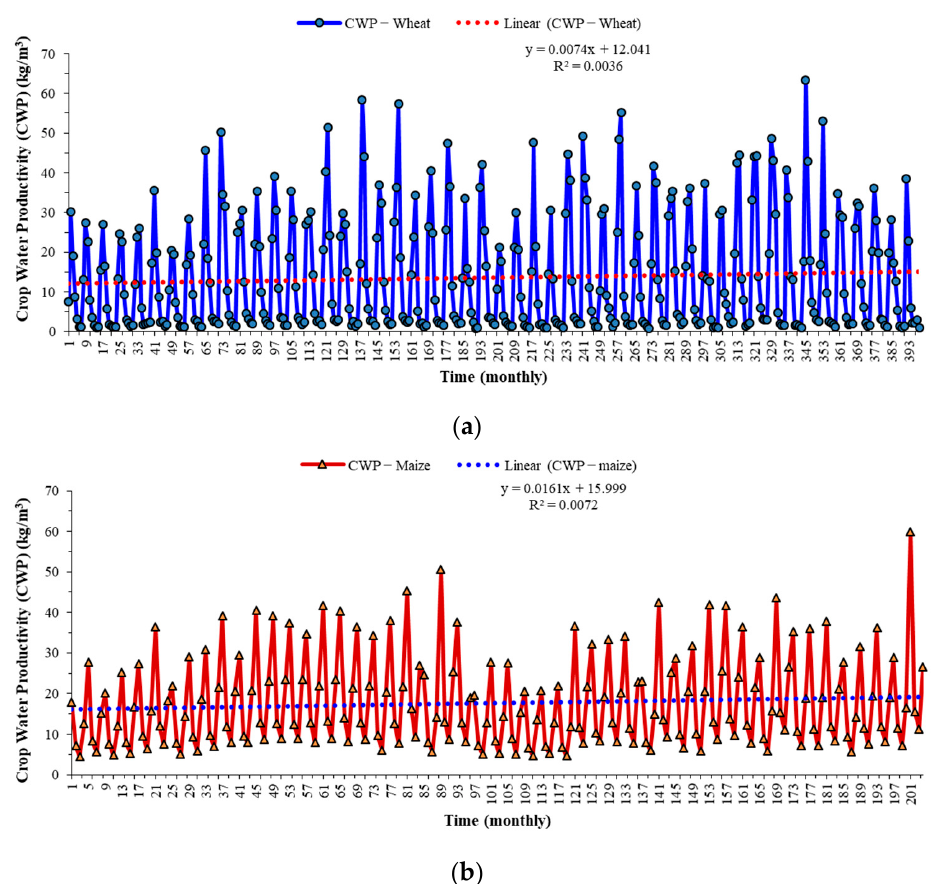
Figure 6. Trend analysis of crop water productivity (CWP) for ( a ) wheat and ( b ) maize across the study period 1969–2019.